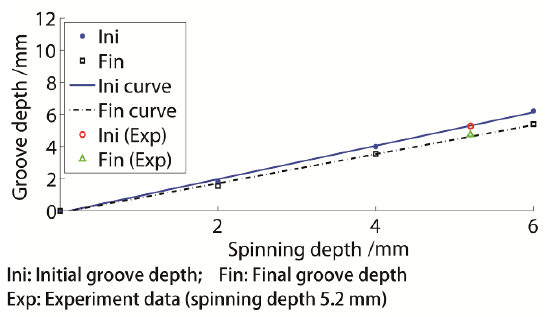
Figure 15. Groove depth variation of three-groove sheave.